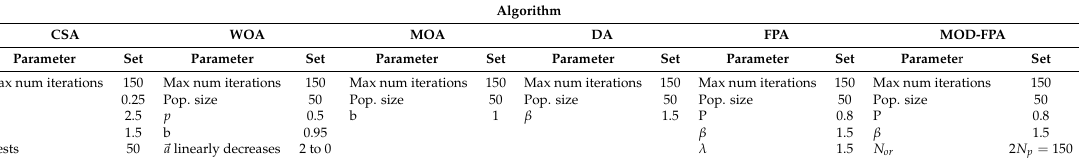
Table 2. Parameter settings for each algorithm.